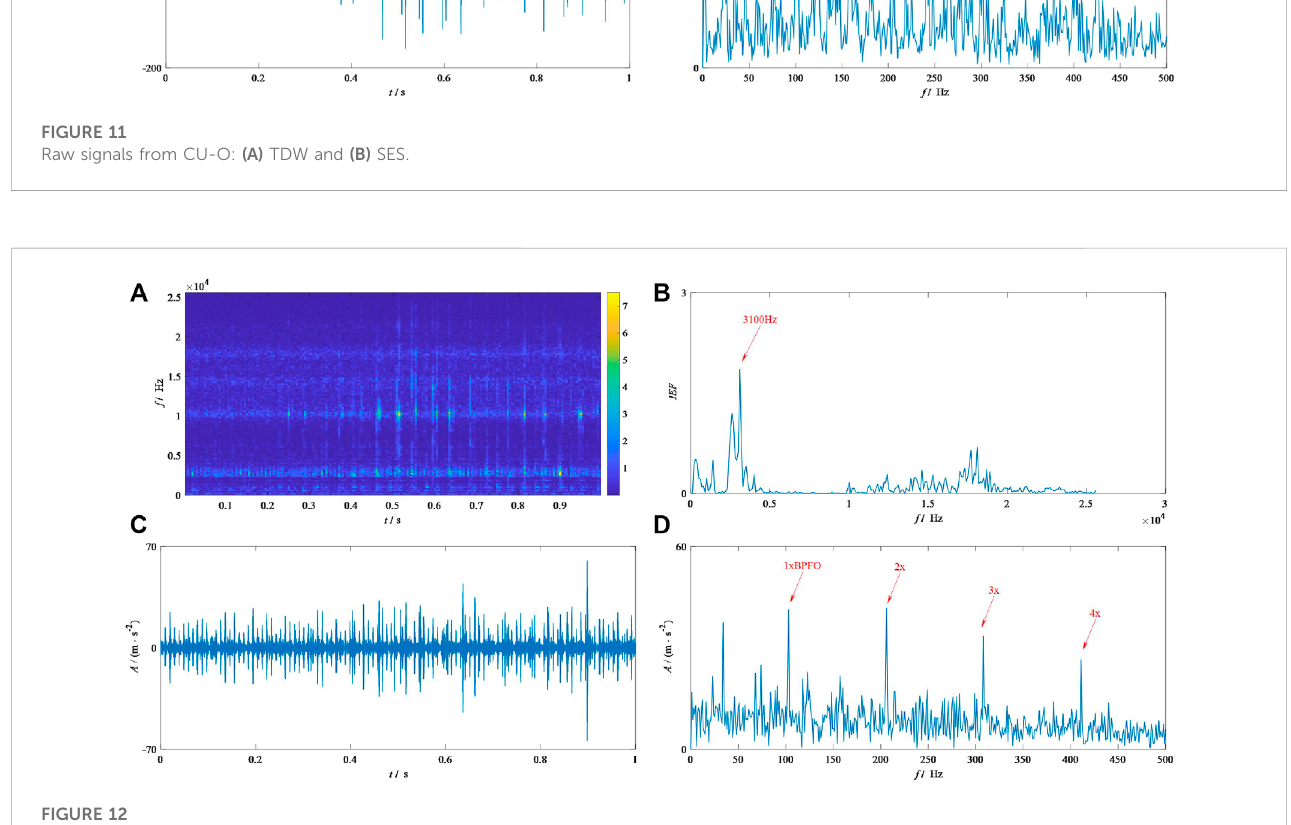
FIGURE 12 Results from IEFI – MVMD: (A) STFT, B) IEFI, (C) TDW, and (D) SES.